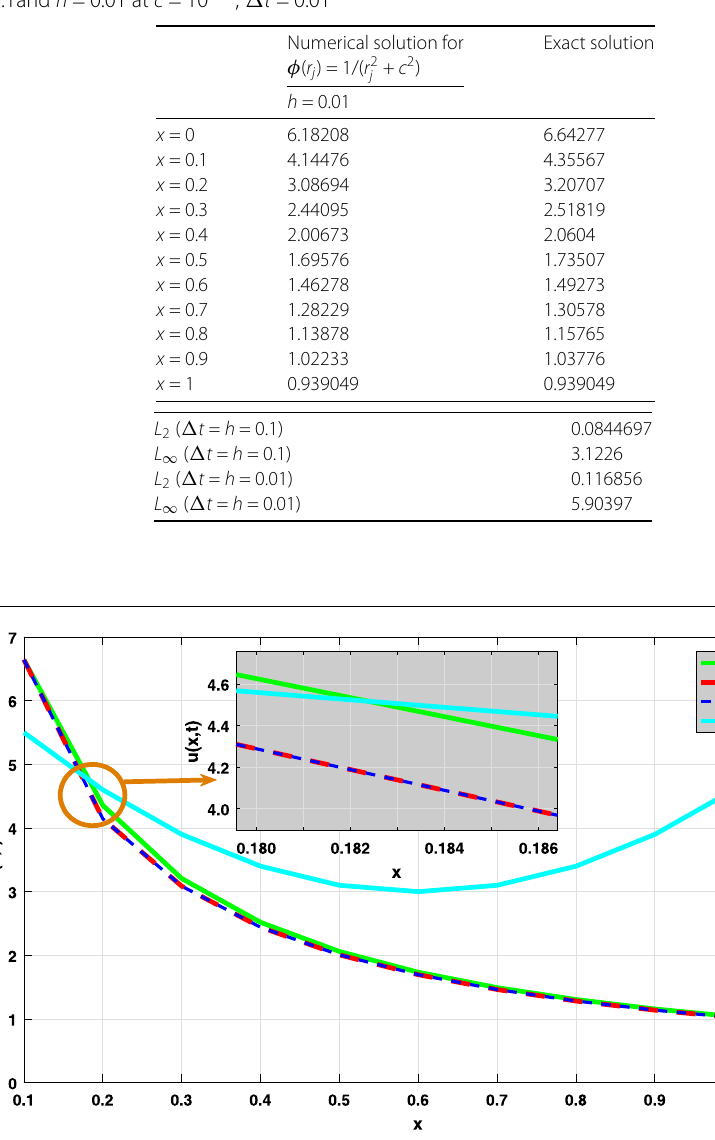
Figure 3 Comparison of the exact solution and the obtained solutions using IQ, MQ, IMQ bases for h =